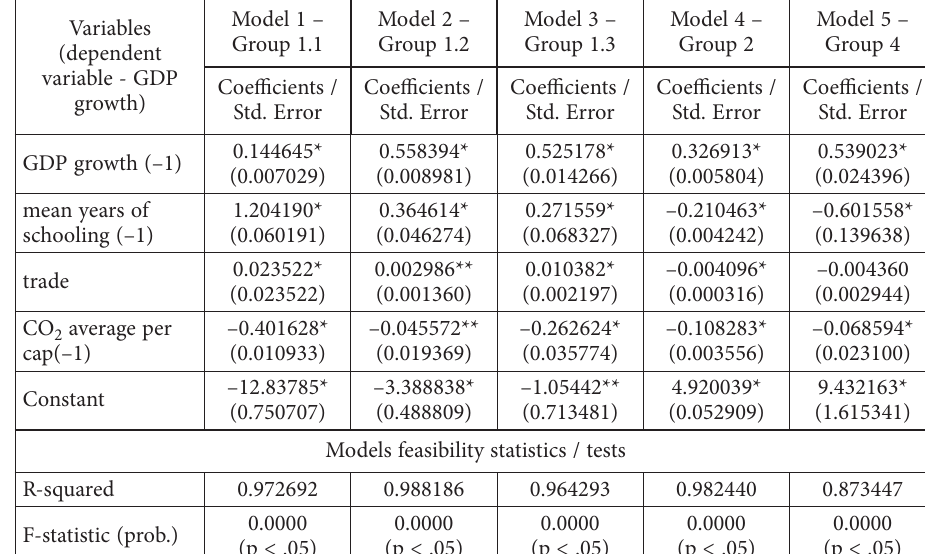
Table 4. Econometric results (source: own calculations using Eviews 9) Variables